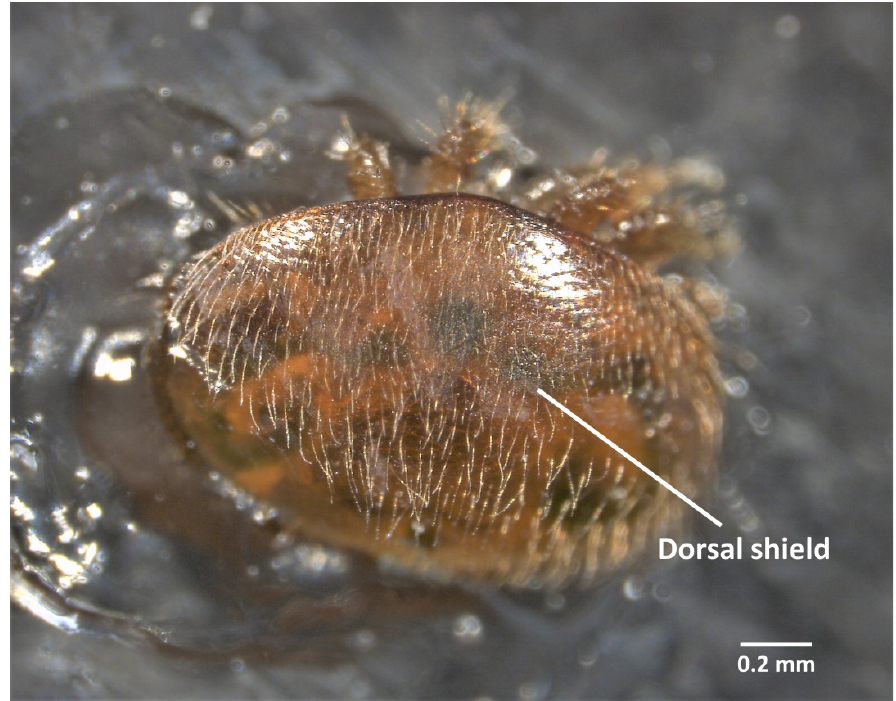
Figure 3. External dorsal view of a V. destructor female before dissection.